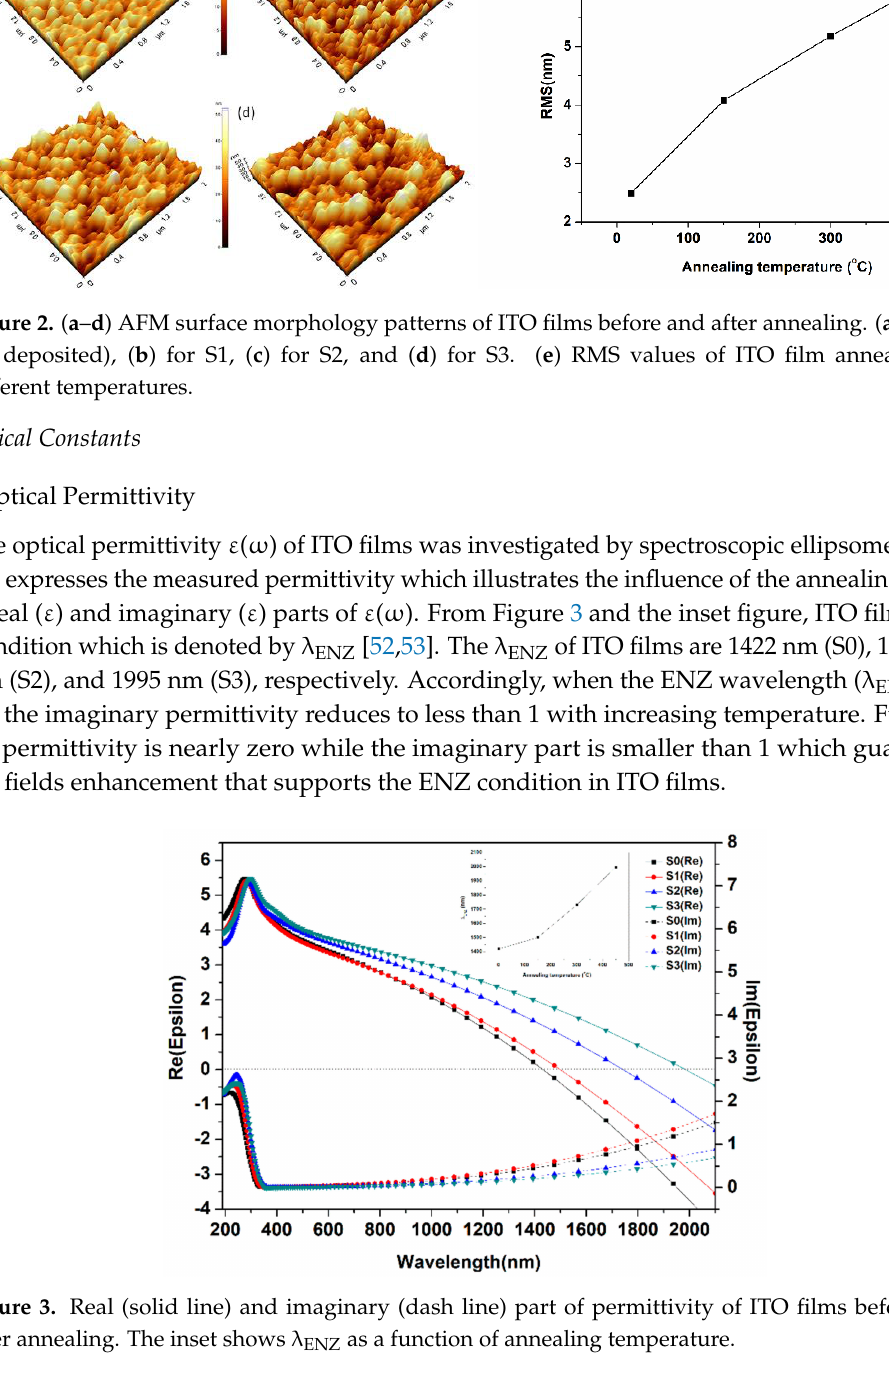
Figure 3. Real (solid line) and imaginary (dash line) part of permittivity of ITO films before and after annealing. The inset shows λ ENZ as a function of annealing temperature.